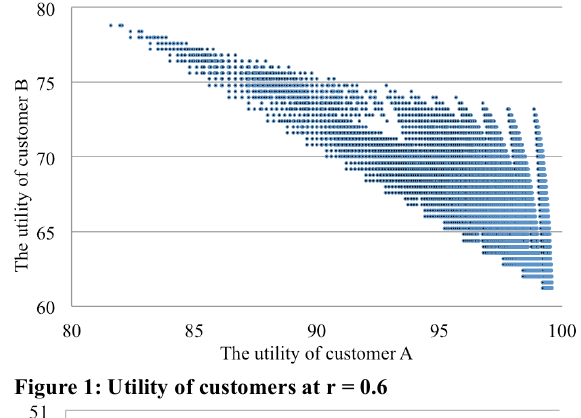
Figure 1: Utility of customers at r = 0.6